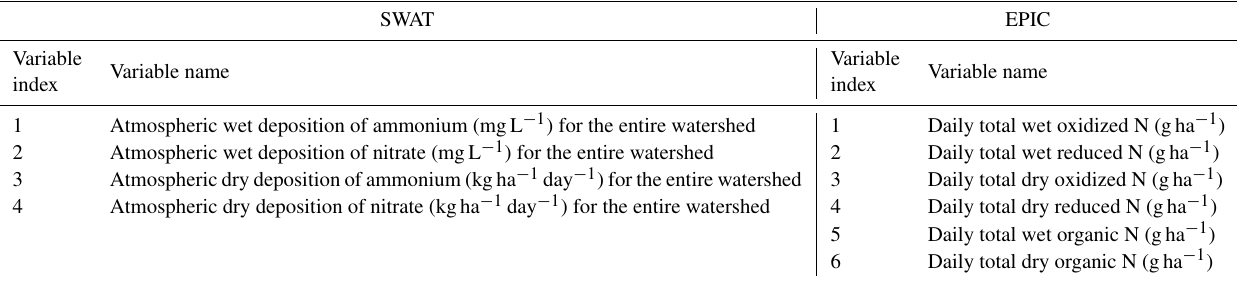
Table 2. N deposition variables used by SWAT and